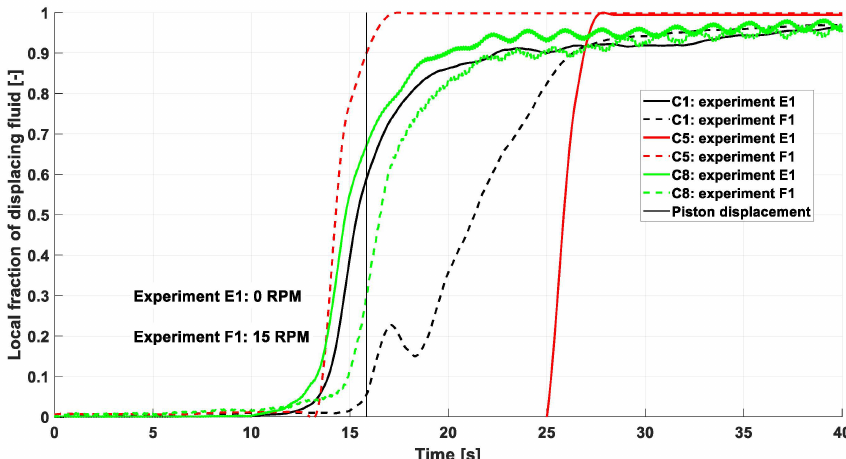
Figure 17. Effect of inner pipe rotation on displacement in inclined wellbore (60 degrees from vertical) with eccentric annulus (e = − 0.42). Curves showing fraction of displacing fluid at station C (near inlet to washout section) without inner pipe rotation (experiment E1) and with inner pipe rotation (experiment F1). Azimuthal positions of probes (1, 5 and 8) are as shown in Figure 6.